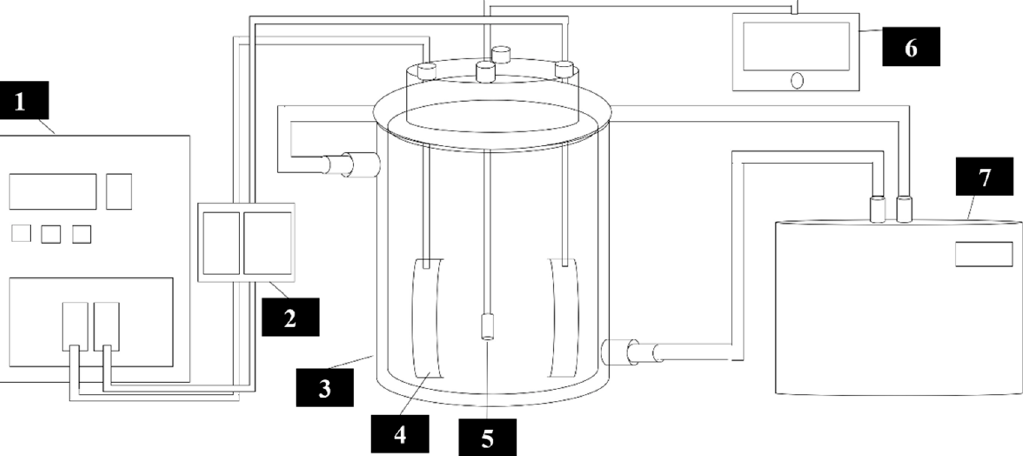
Figure 1. A schematic representation of the ohmic heating extraction-based valorization system designed and developed in the emerging food processing laboratory of the National Pingtung University of Science and Technology. 1: Power supply equipped with online monitoring system. 2: Automatic monitoring and recording device. 3: Extraction chamber. 4: Ohmic electrode. 5: K-type thermocouples. 6: Twelve-channel temperature monitoring system. 7: Temperature regulating system for the conventional heating treatment.